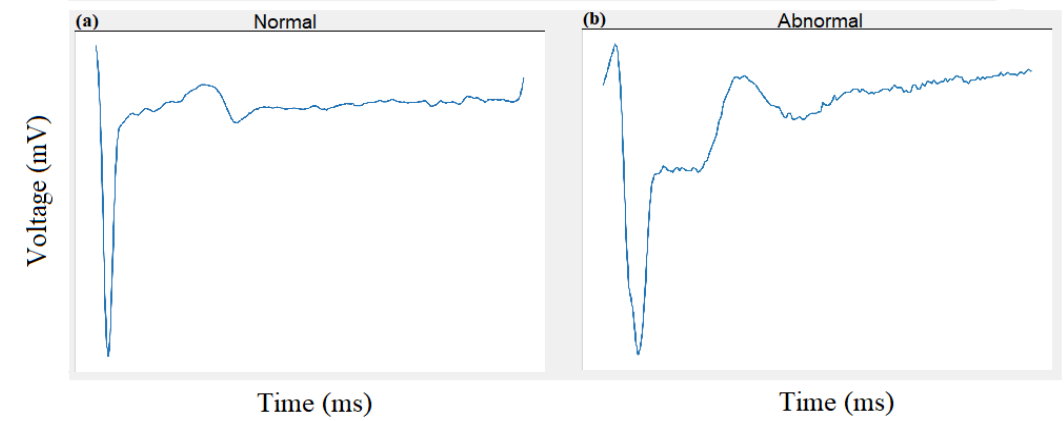
Figure 7. Experiment 1: Classification of Normal ( a ) and Abnormal ( b ) beats using 2-D CNN.